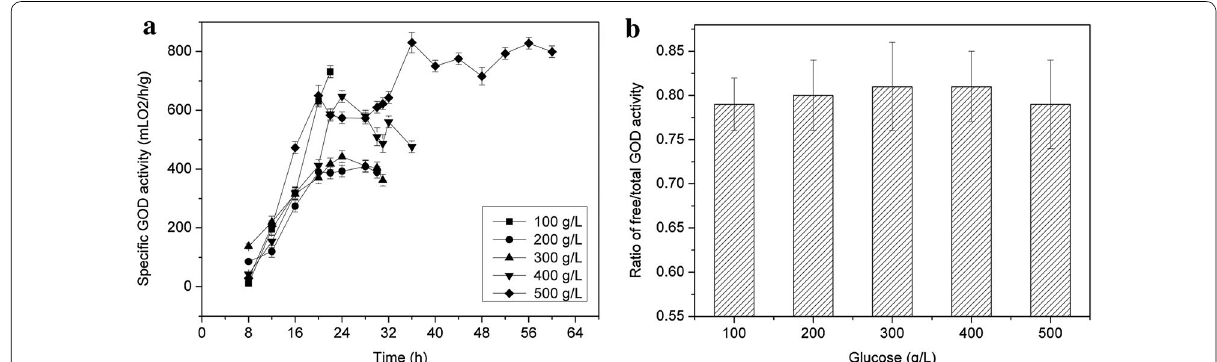
Fig. 4 Effects of different initial glucose concentrations on the specific GOD activity ( a ) and the ratio of free/total GOD activity ( b ) in seed culture of A.